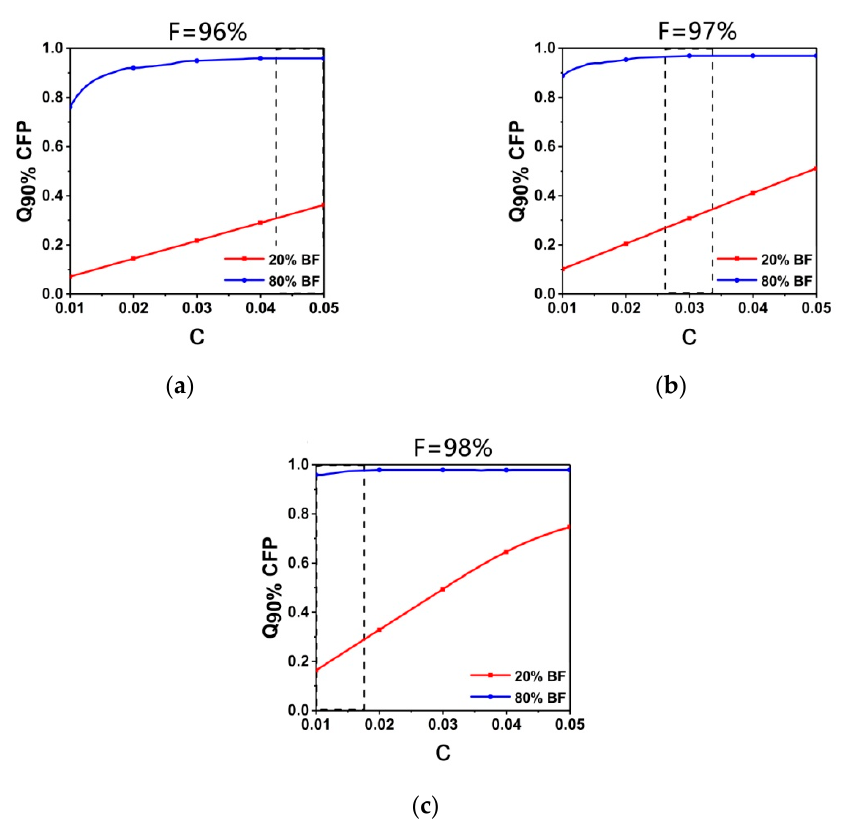
Figure 4. The distribution of Q 90%CFP with different blinking frequency (BF) and step size of updating CFP ( a ) forgetting factor = 0.96, ( b ) forgetting factor = 0.97, ( c ) forgetting factor = 0.98. Table 1. Typical selection of parameters and